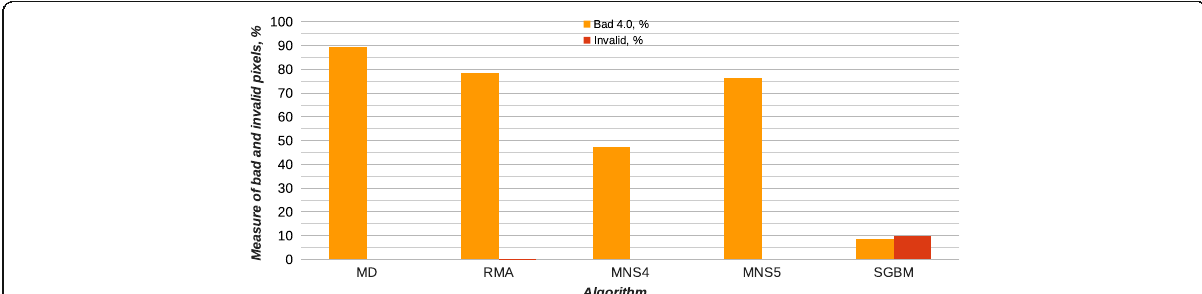
Fig. 10 Average percentage of bad pixels, whose error is larger than 4 pixels, and average percentage of invalid pixels. Evaluation performed using H resolution training set